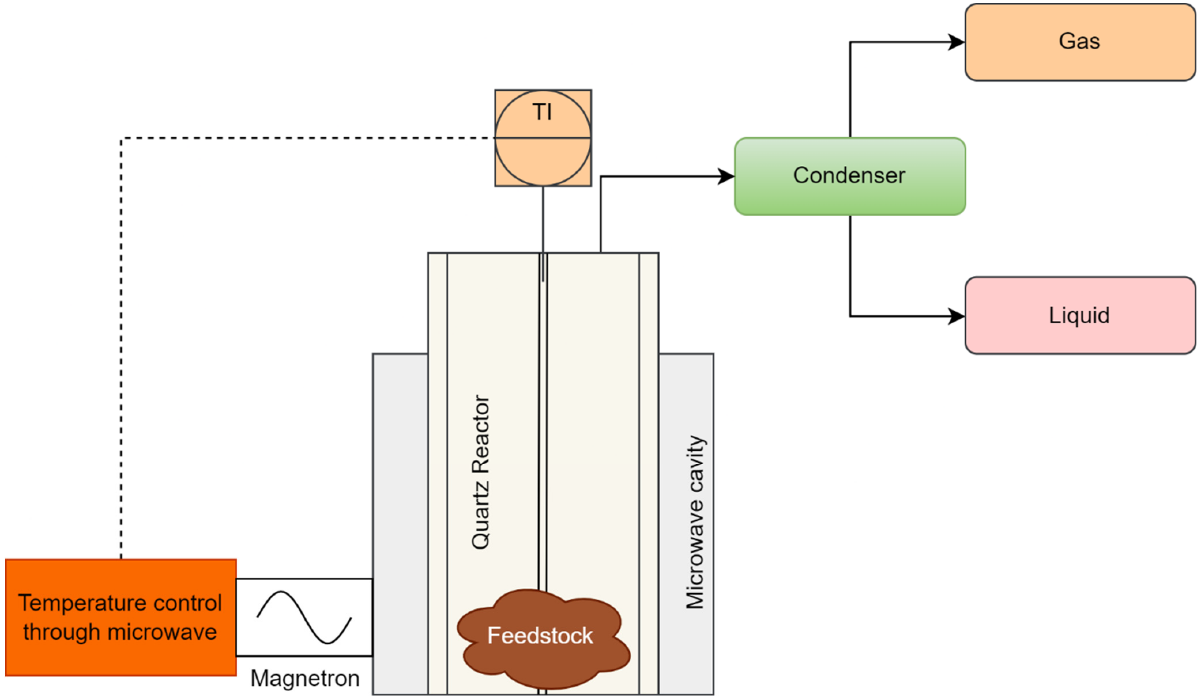
Figure 6. Microwave heat reactor adapted from